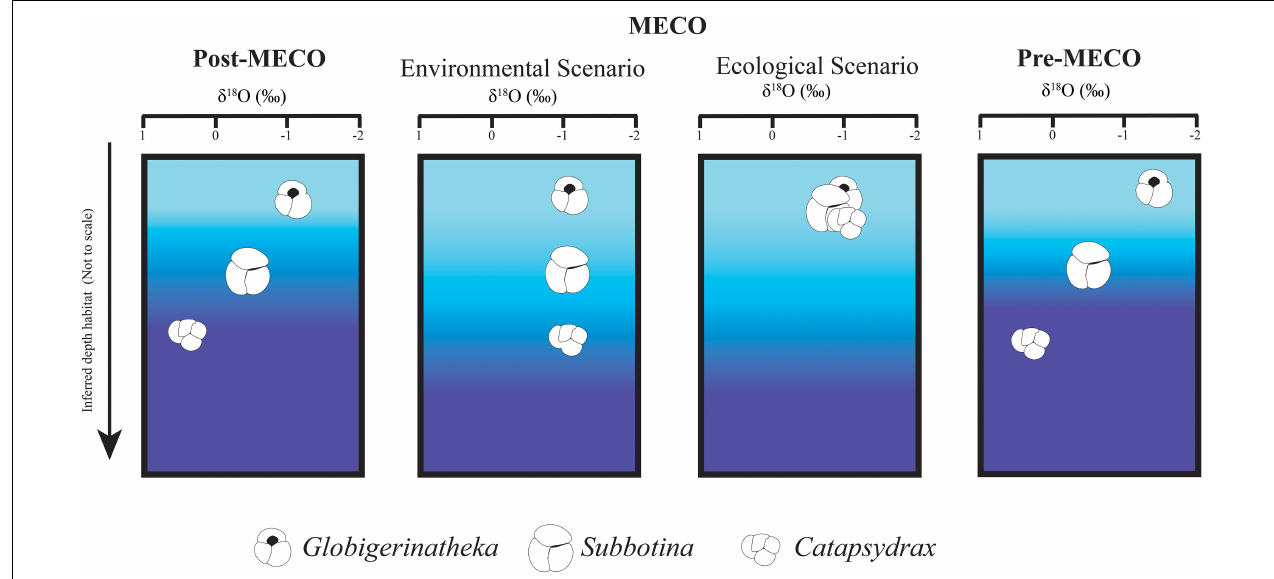
FIGURE 6 | Schematic illustration of environmental versus ecological scenarios to explain the δ 18 O isotopic gradient changes between genera. Color gradient in all panels represents temperature change from warm (light blue) to cool (darker blue)